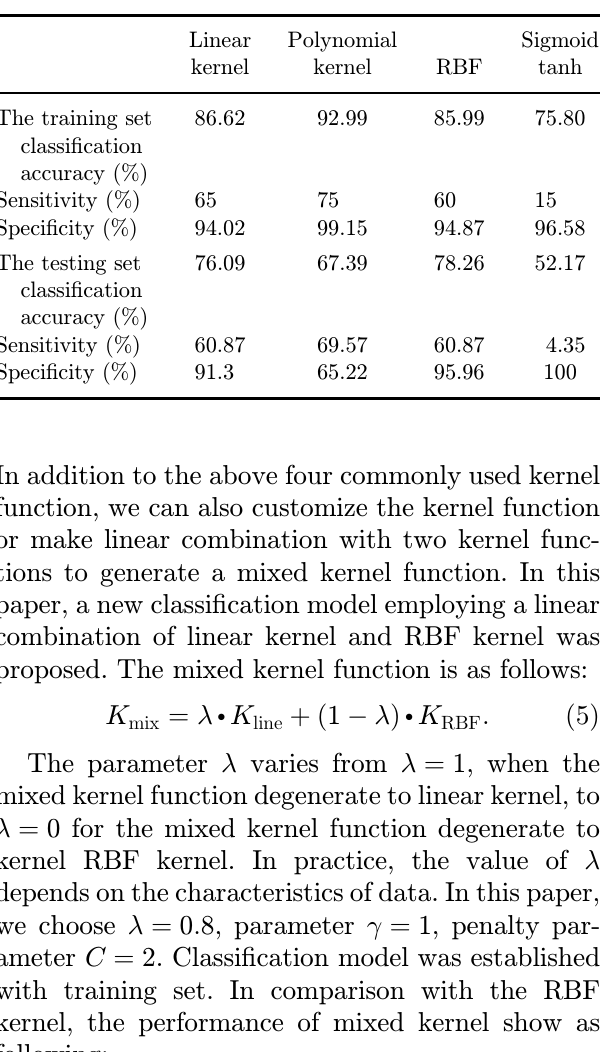
Table 2. Results of classi¯cation with four di®erent kernels.